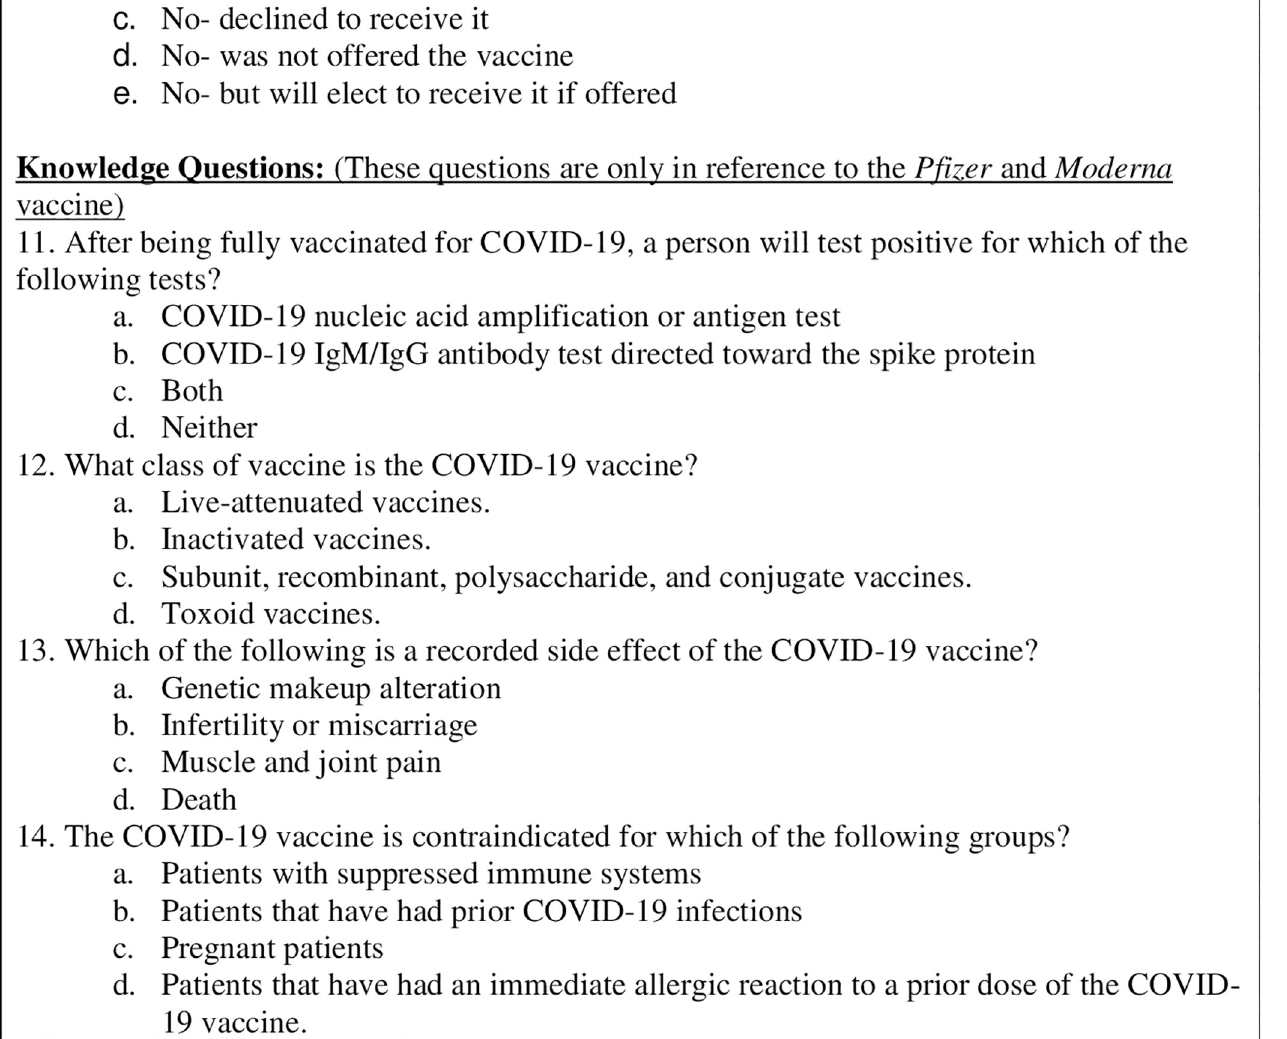
PLOS ONE | https://doi.org/10.1371/journal.pone.0260898 December22, 2021 4 /